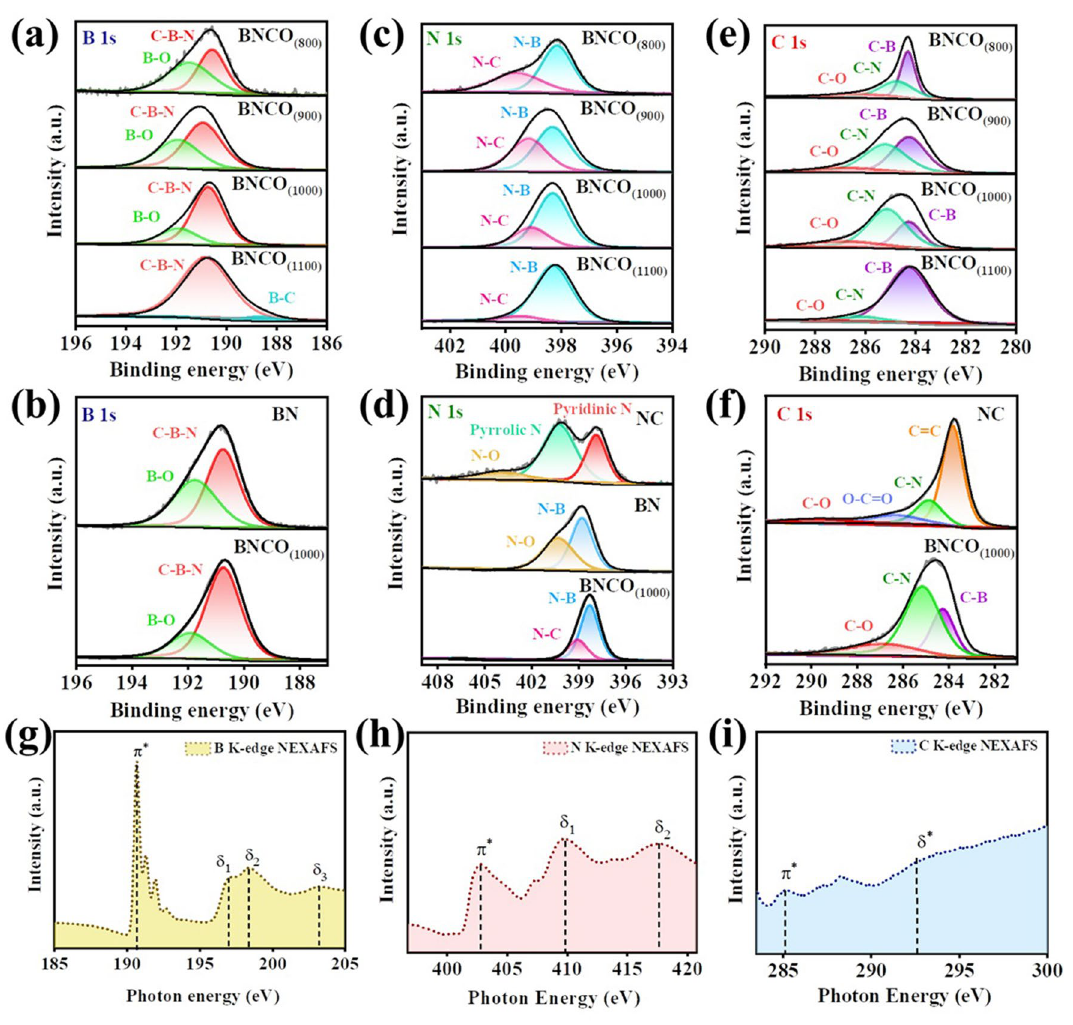
Fig. 3 Comparative narrow XPS spectra of all the catalysts at a, b B 1 s , c, d N 1 s , e, f C 1 s edges. NEXAFS spectra of BNCO (1000) catalyst at g B K -edge, h N K -edge, and i C K